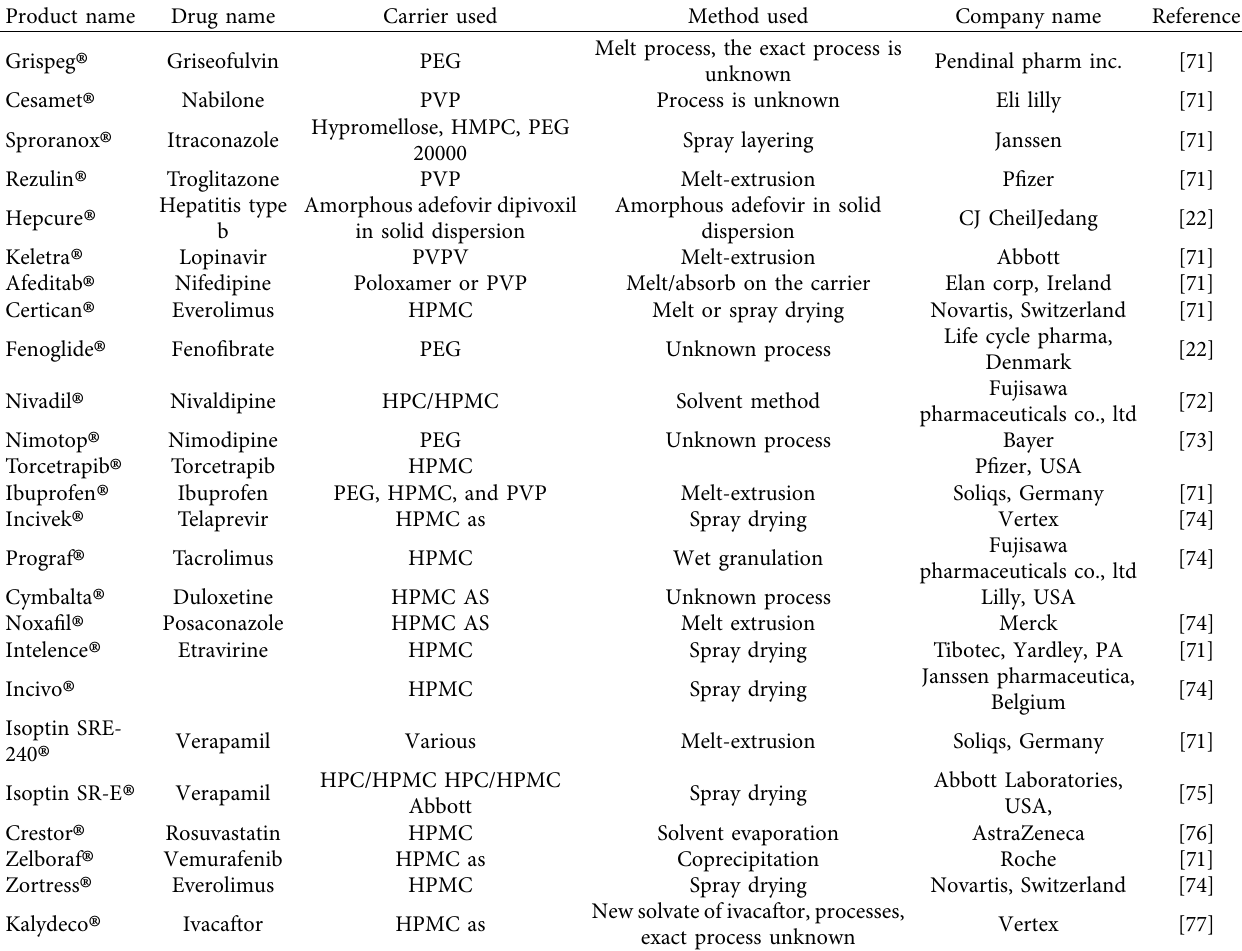
Table 8: Marketed products [70].